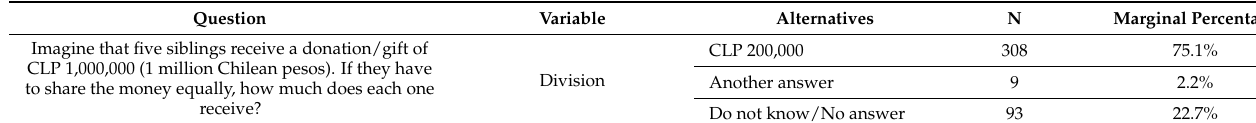
Table 1. Model variable descriptor of multinomial logistic